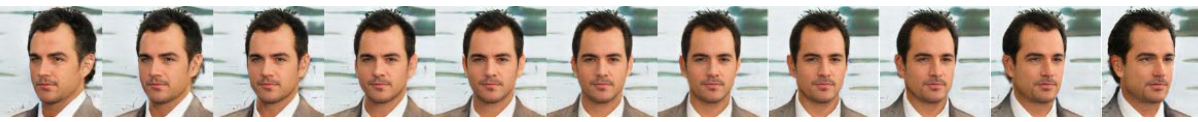
Figure 3. Generated identity face images in different view.